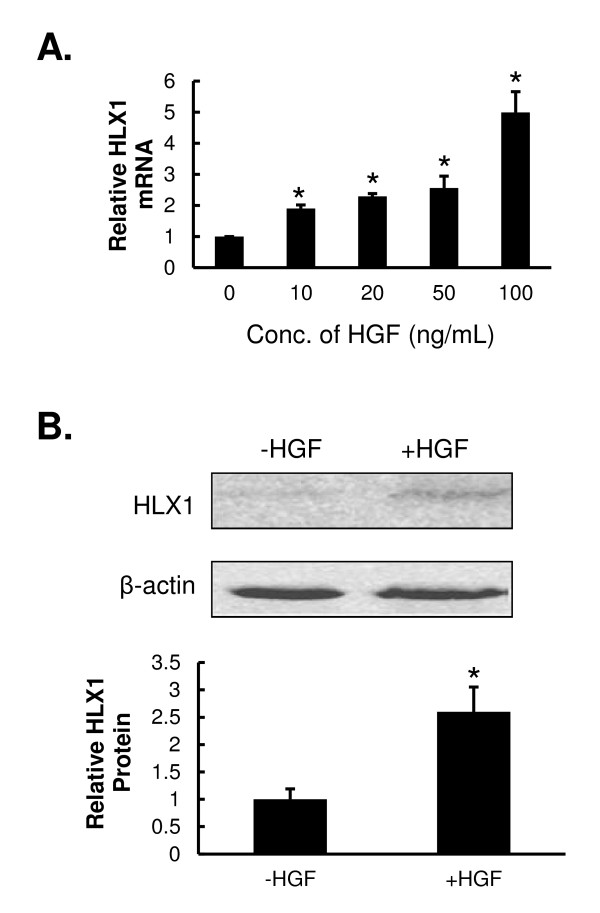
HGF up-regulates the expression of HLX1 in HTR-8/SVneo cells. (A) HTR-8/SVneo cells were treated with the indicated concentrations of HGF for 48 h. The steady-state mRNA level of HLX1 was examined by qPCR and normalized to a β-actin internal control. The ratio of HLX1/β-actin mRNA in cells treated with 0 ng/mL HGF was arbitrarily defined as 1. Data are presented as mean ± SD for three independent experiments. *P < 0.01, vs. 0 ng/mL HGF. (B) HTR-8/SVneo cells were treated with 0 ng/mL (−) or 20 ng/mL (+) HGF for 48 h. The protein level of HLX1 was determined by Western immunoblot and normalized to β-actin internal control. A representative gel image is presented in the upper panel and quantification of HLX1 to β-actin signal ratio from three independent experiments is shown in the lower panel. The ratio in –HGF cells was arbitrarily defined as 1. *P < 0.01, vs. 0 ng/mL HGF.